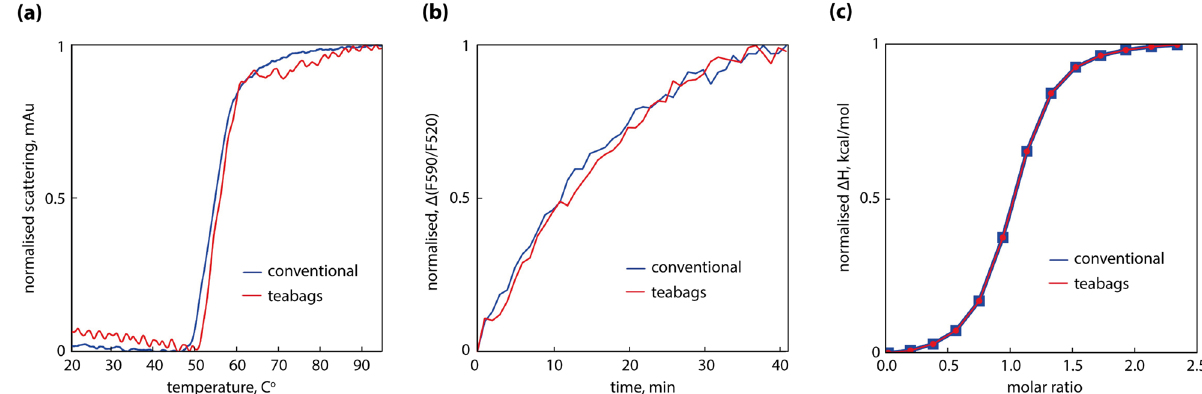
Figure 3. Quality assessment of purified MraY and comparison between conventional (blue) and teabag purification (red). ( a ) Nano DSF thermal stability; ( b ) FRET based activity assay; ( c ) Tunicamycin binding as measured by